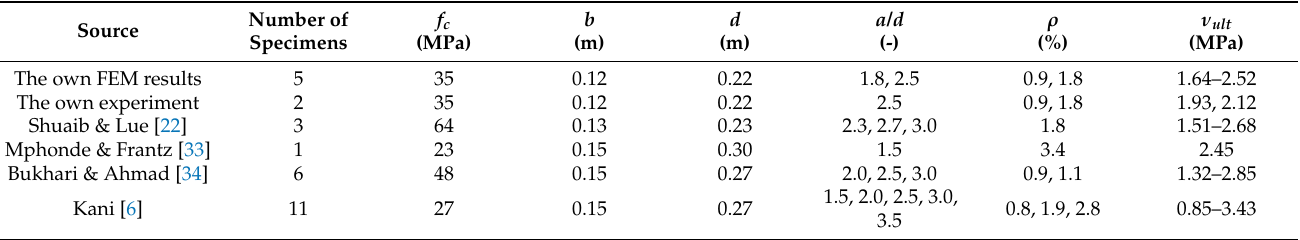
Figure 15. Comparison of strain intensity for the short beams S1k (2 φ 18, f y = 453 MPa) and PI-1 (2 φ 18, f y = 548 MPa). Table 5. Data of test results completed for the